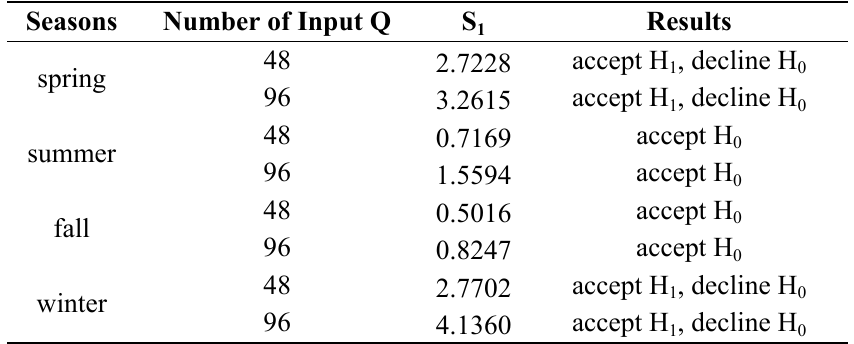
Table 14. Diebold and Mariano Test between the proposed hybrid PCA and BP-based neural network (Byberry).